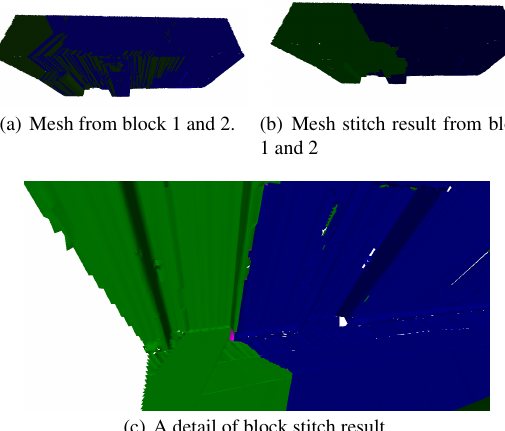
Figure 15. A block stitching experiment. Block 1 is in ,